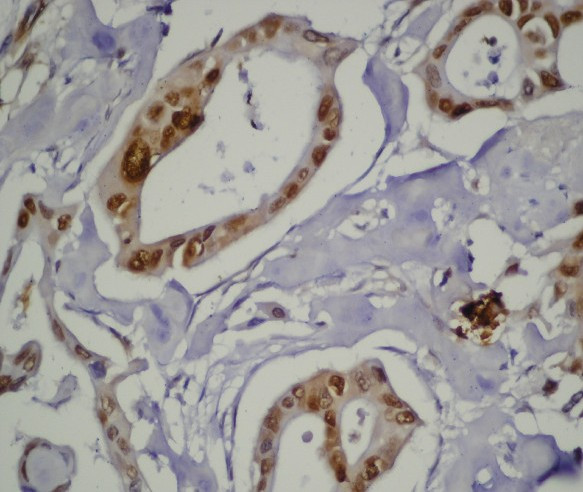
High level nuclear p27 immunoreactivity of pancreatic carcinoma cells [anti-p27, original magnification, × 400].